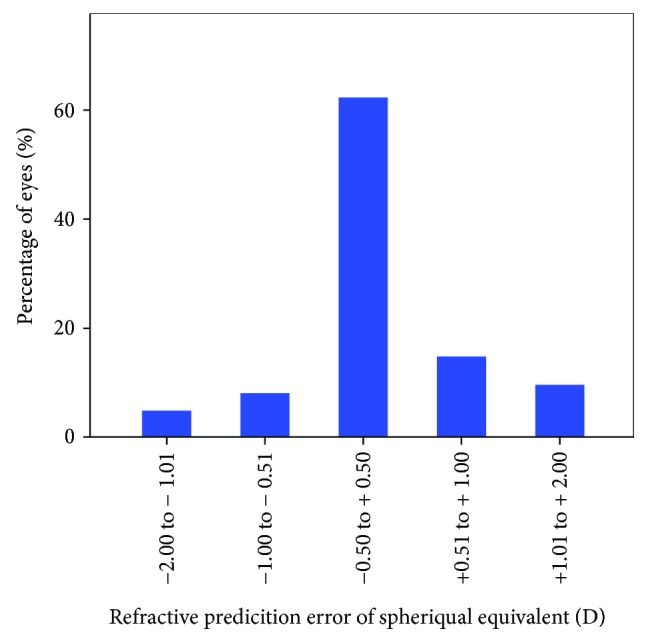
Percentage of eyes within a certain range of refractive prediction error (spherical equivalent) when using a standard industry-based calculator.